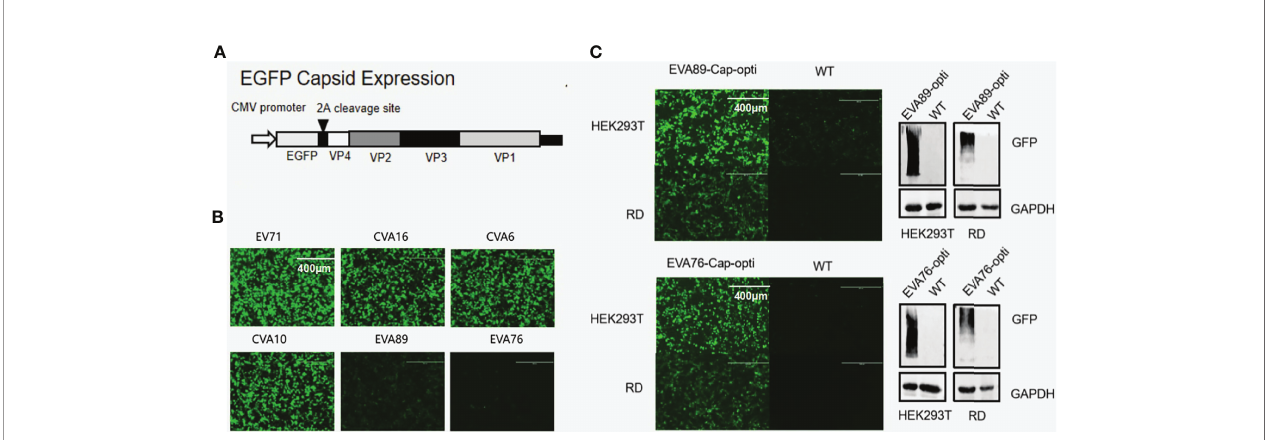
FIGURE 9 | Codon optimization and protein expression levels for EV-A strains. (A) Schematic map of P1 protein expression plasmid. (B) Post plasmid transfection, GFP-tagged P1 protein levels of different EV-A strains in HEK293T cells was monitored by fl uorescence microscopy. (C) Comparison of EVA76 and EVA89 P1 protein levels before and after codon optimization. Expression of GFP-tagged P1 protein in the cell culture was monitored through fl uorescence microscopy (left panel). Furthermore, the expression of GFP-tagged P1 proteins was examined by anti-GFP antibodies using Western Blot (right panel). Housekeeping gene GAPDH was used for loading control.